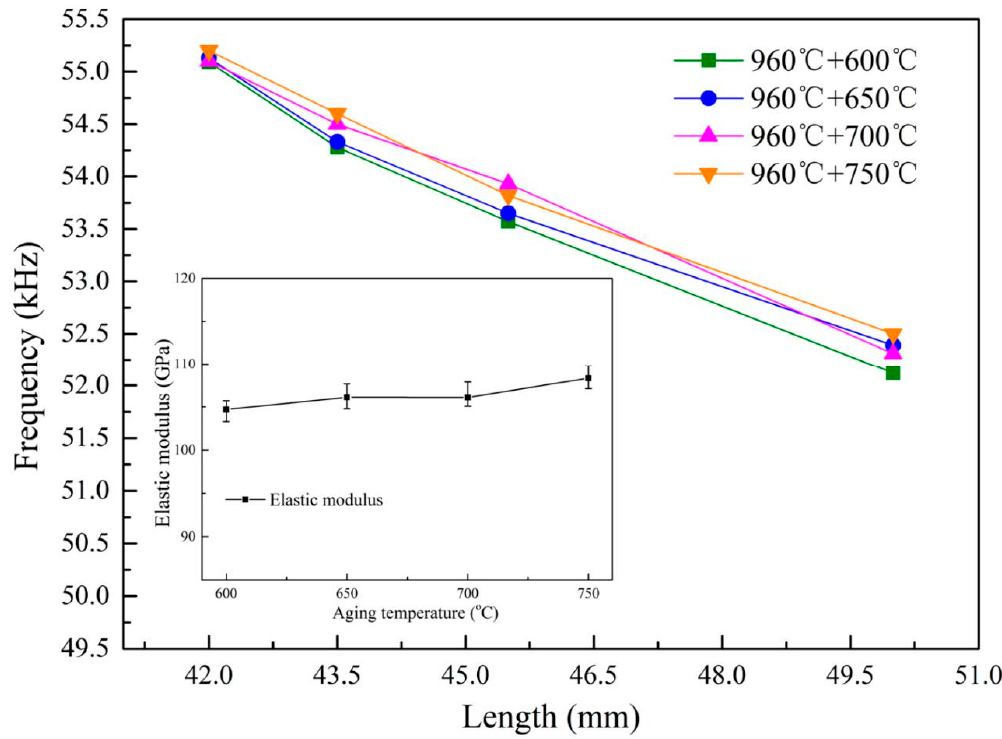
Figure 5. Dependence of the resonant frequency on the aging temperature and the sample length of Ti6Al4V alloy vibrator.